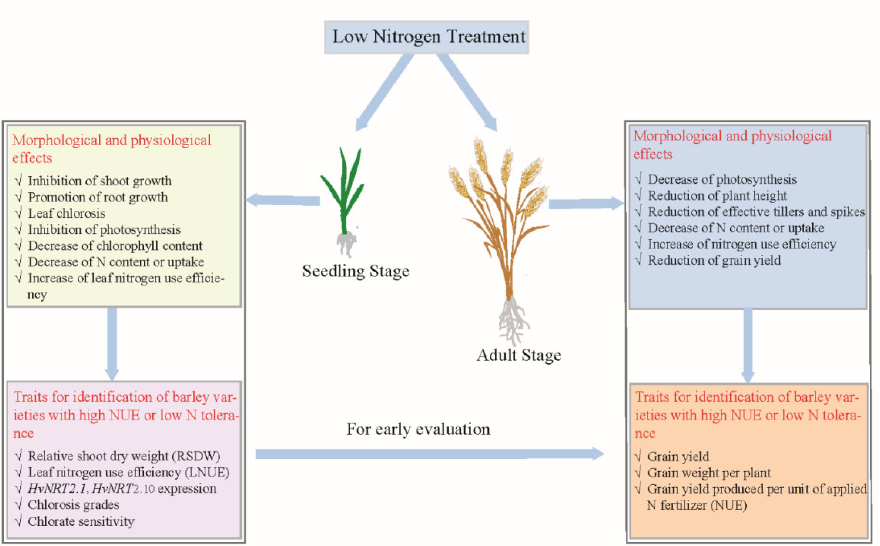
Figure 1. The effects of low nitrogen treatment on barley at seedling and adult stages and the related traits for identification of barley varieties with high NUE or low nitrogen tolerance.